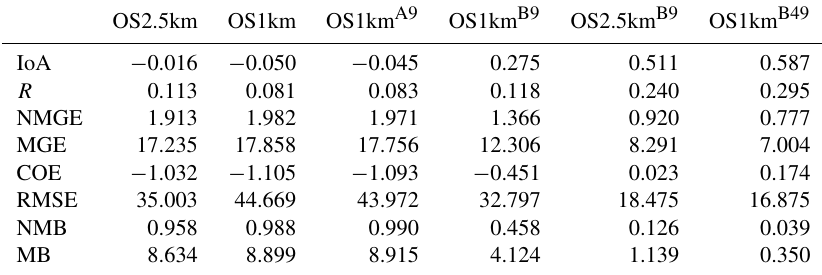
Table B4. Surface NO x observations to model comparison, nighttime (18:00–09:00LT) (ppbv, 1862 model–observation